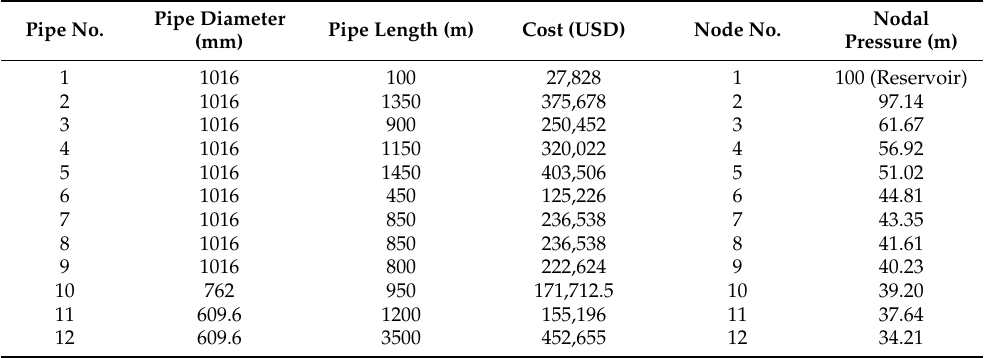
Table 8. SOP–WDN results for the Hanoi